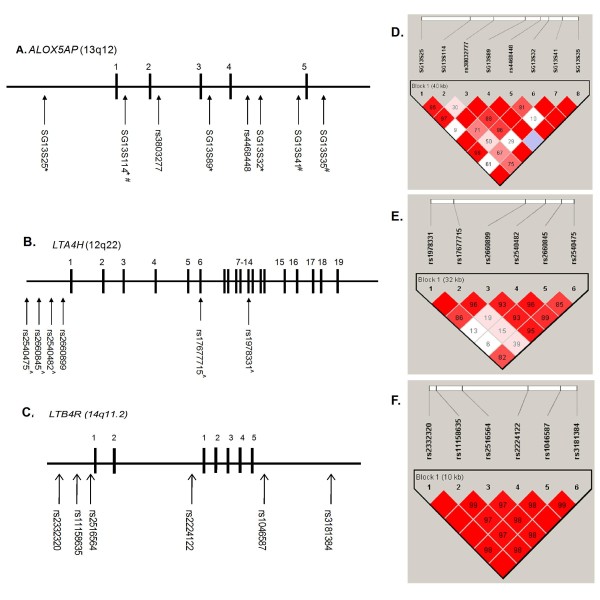
Location of SNPs genotyped in ALOX5AP, LTA4H and LTB4R in the smokers and linkage disequilibrium (LD) plot. The LD plot shows the LD displayed as D'/LOD in Haploview software. Numerical values shown correspond to D'. A-C. represents the physical location of the SNPs genotyped in ALOX5AP, LTA4H and LTB4R, respectively. Black boxes represent exons and the spaces between represent introns. D. E. and F. represents the LD plot in the smokers (n = 992) for each loci respectively..* represents SNPs that define the haplotype HapA, #which define HapB and ^ which define the haplotype (HapK) previously associated with MI [11,12].